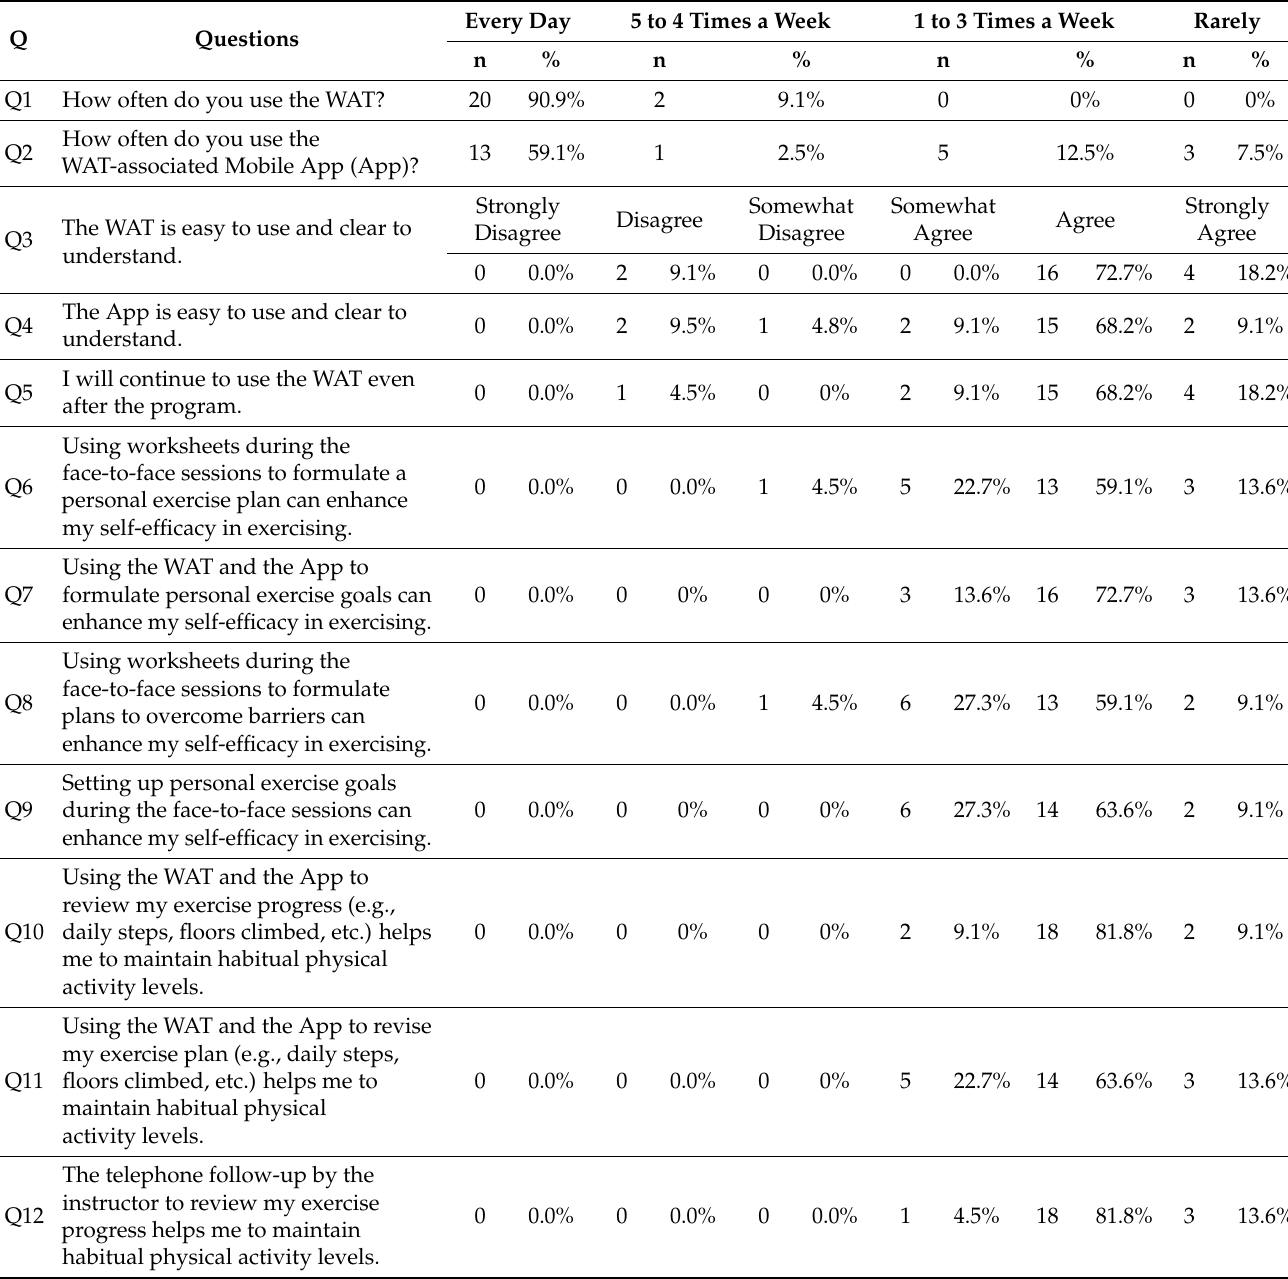
Table 4. Results from the feedback questionnaire completed by the WAT participants ( n =